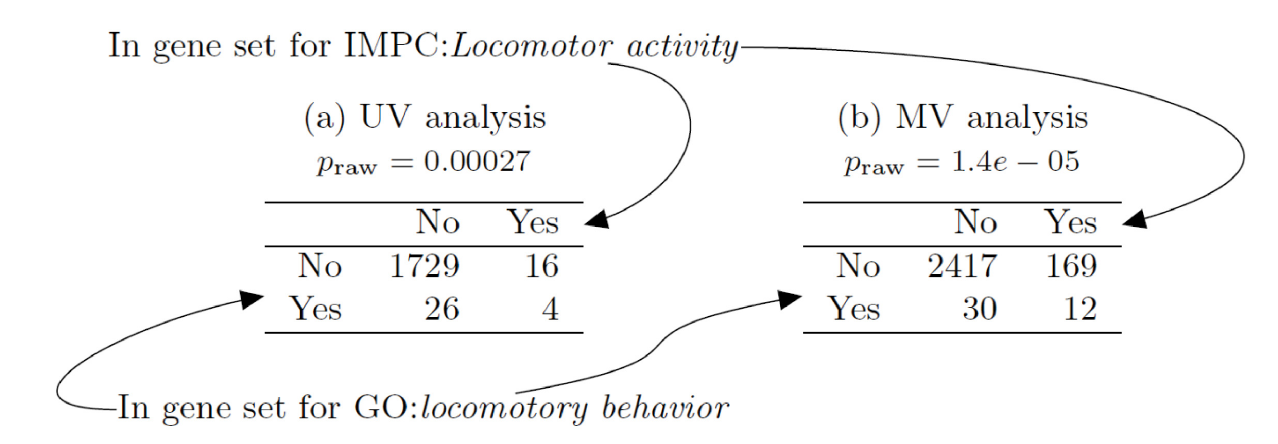
Fig 7. Illustrative 2-by-2 contingency tables for co-enrichment testing. (a) UV model; (b) MV model. Each contingency table allocates each gene to one of 4 categories according to whether it is in the GO term gene set (left) and/or IMPC phenotype gene set (top). Fisher exact test p -values are shown above each table. GO, Gene Ontology; IMPC, International Mouse Phenotyping Consortium; MV, multivariate; UV, univariate.